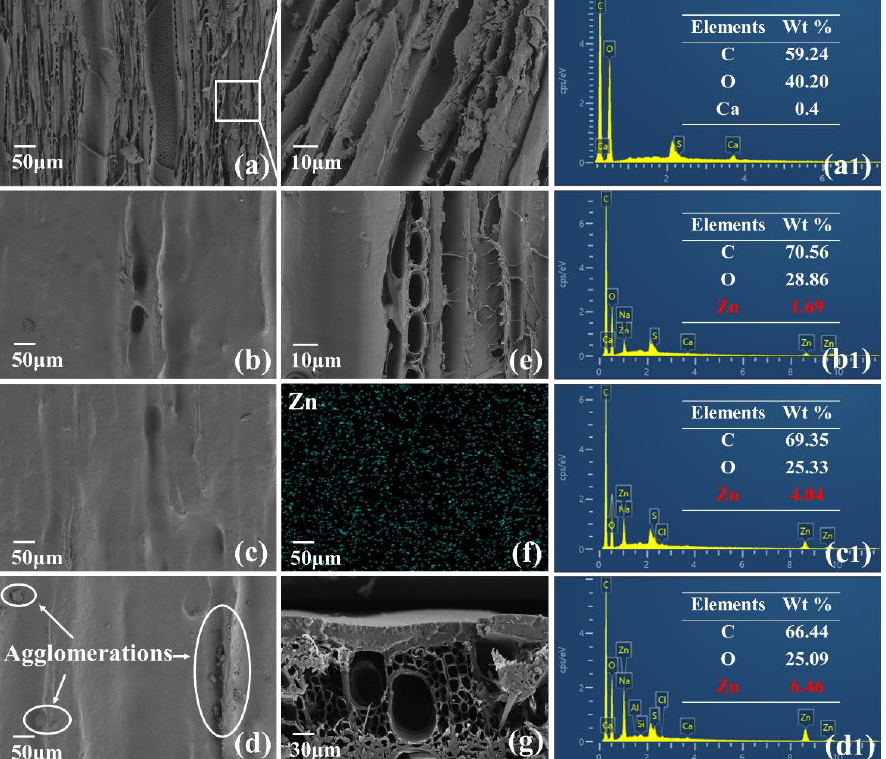
Figure 3. SEM micrographs of ( a ) dyed wood and ( b ) dyed wood treated with ZnO-0.5%, ( c ) treated with ZnO-1%, ( d ) treated with ZnO-2%; ( e ) dyed wood coated with carboxymethyl chitosan; ( f ) EDS mapping of ( c ) Zn; ( g ) cross-section of treated wood; the EDS spectra of ( a1 ) image ( a ), ( b1 ) image ( b ), ( c1 ) image ( c ) and ( d1 ) image ( d ).